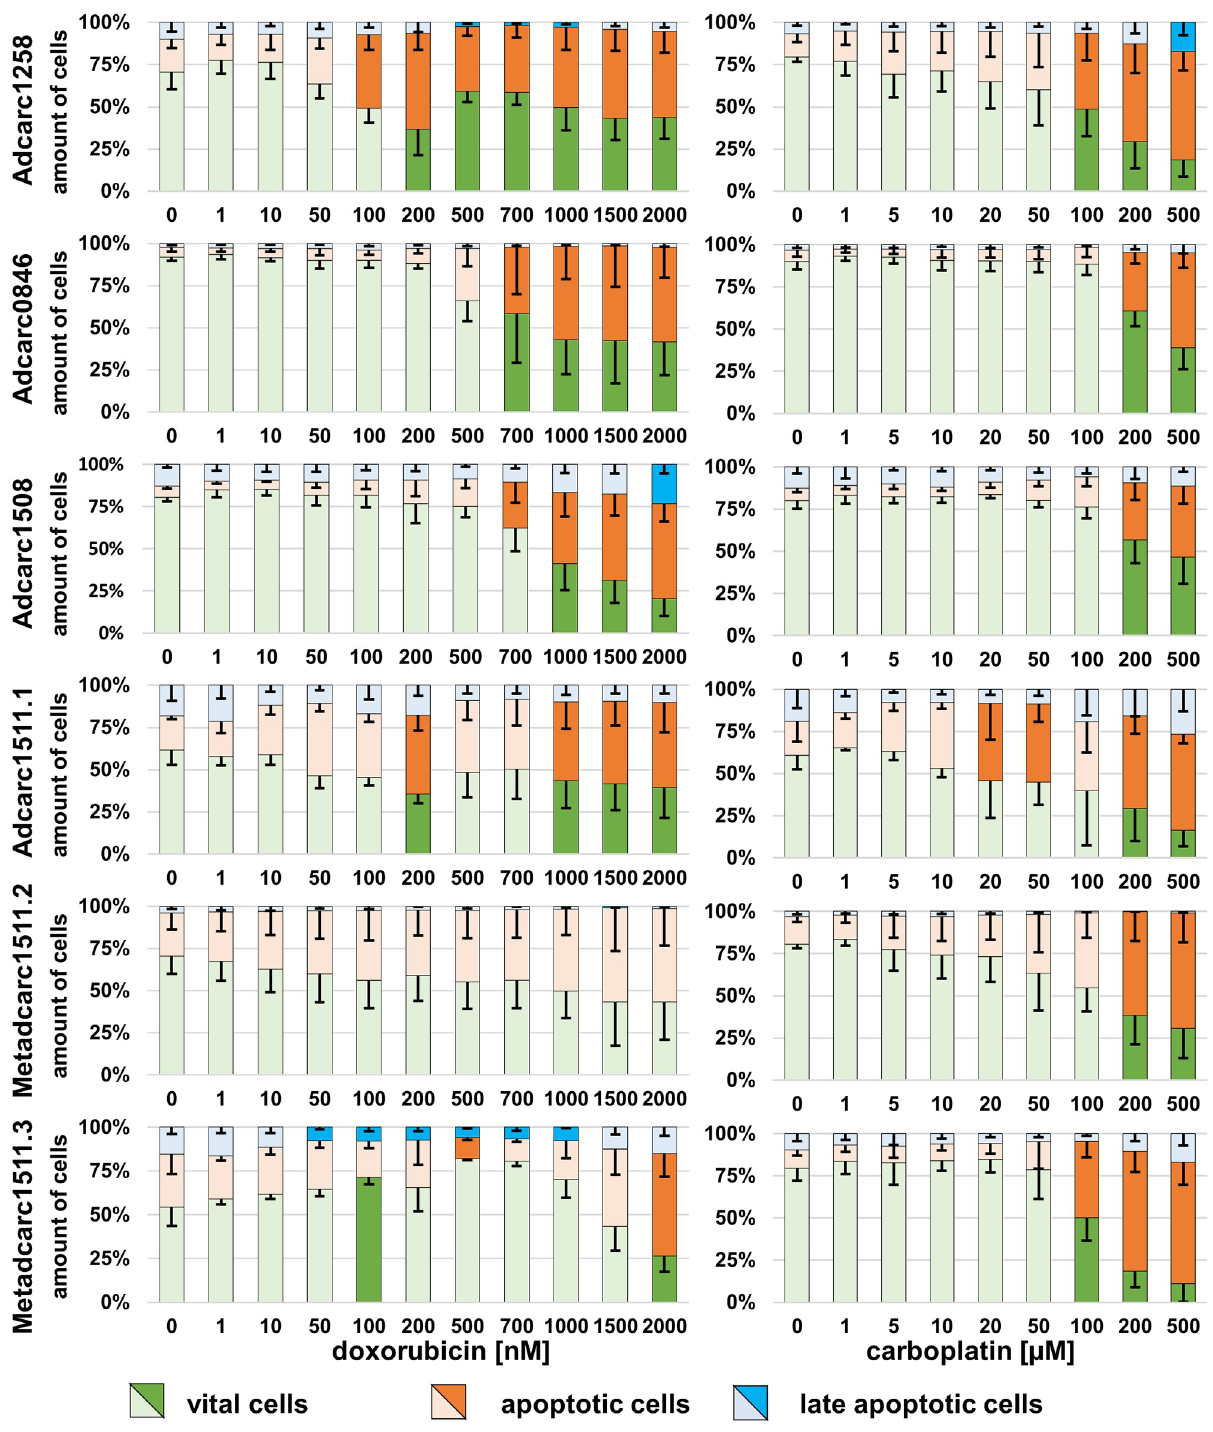
Fig 7. Induction of apoptosis in PAC cell lines after 72 h incubation with doxorubicin or carboplatin. Vital (green), apoptotic (orange) and late apoptotic (blue) proportions of PAC cell lines; means and standard deviations are displayed. Dark colours display significant differences referred to untreated controls. � p < 0.05; n =